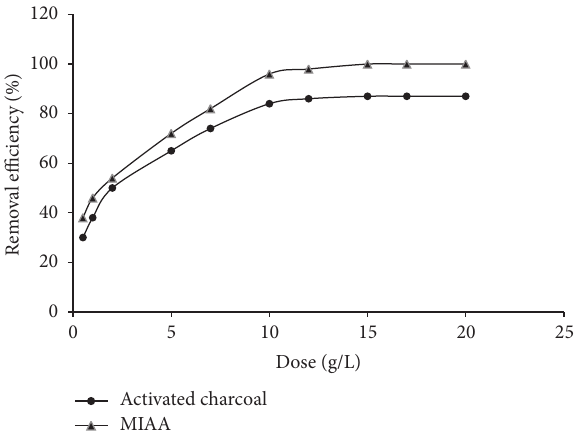
F 4: Effect of stirring rate on adsorption capacity of MIAA and C). activated charcoal at (20 ±